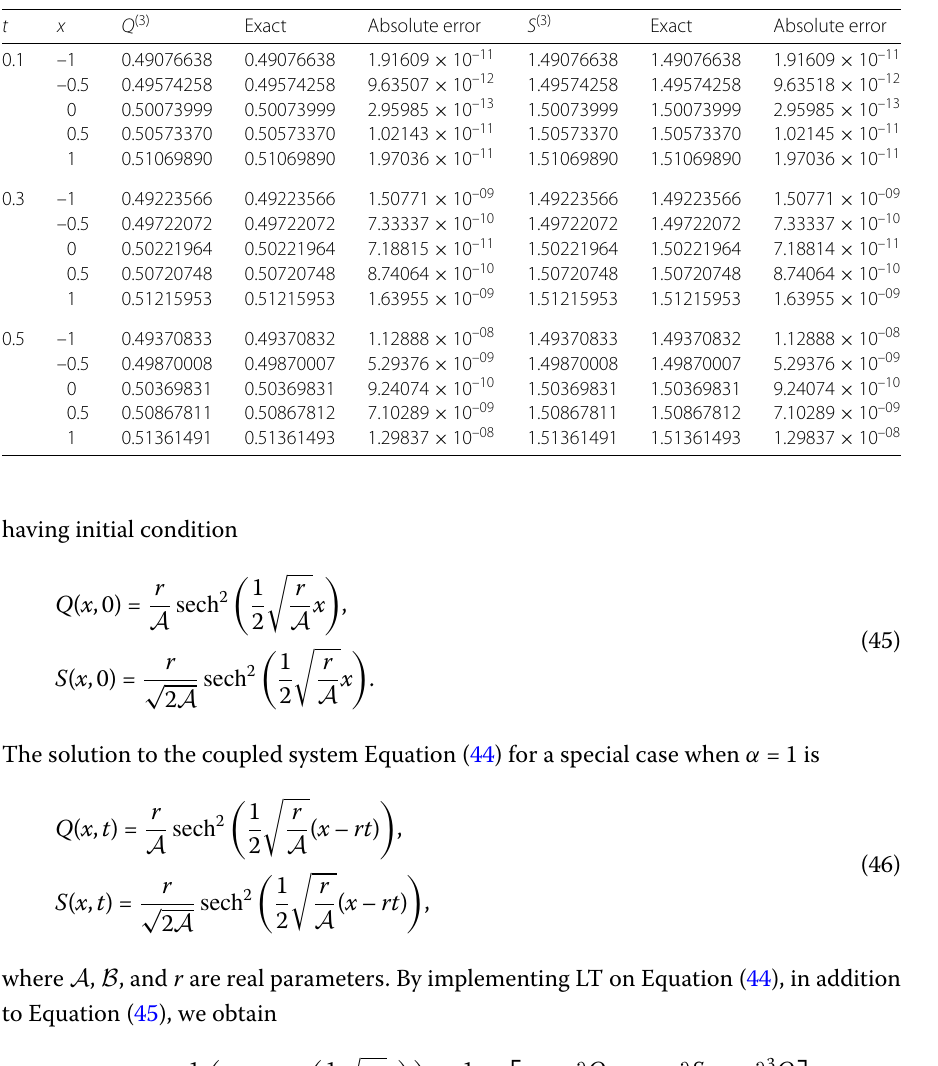
Table 1 The q-HATM solution for Q ( x , t ) and S ( x , t ) for the first three approximations in comparison with the exact solution Equation (35) when α = 1, (cid:2) = –1, k = r = 0.1, λ = 1.5, and n = 1 for Example